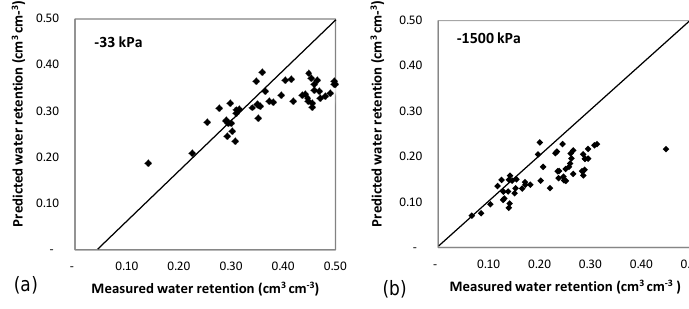
Figure 2. Scatter plots of measured versus predicted soil water retention by Rosetta H2.